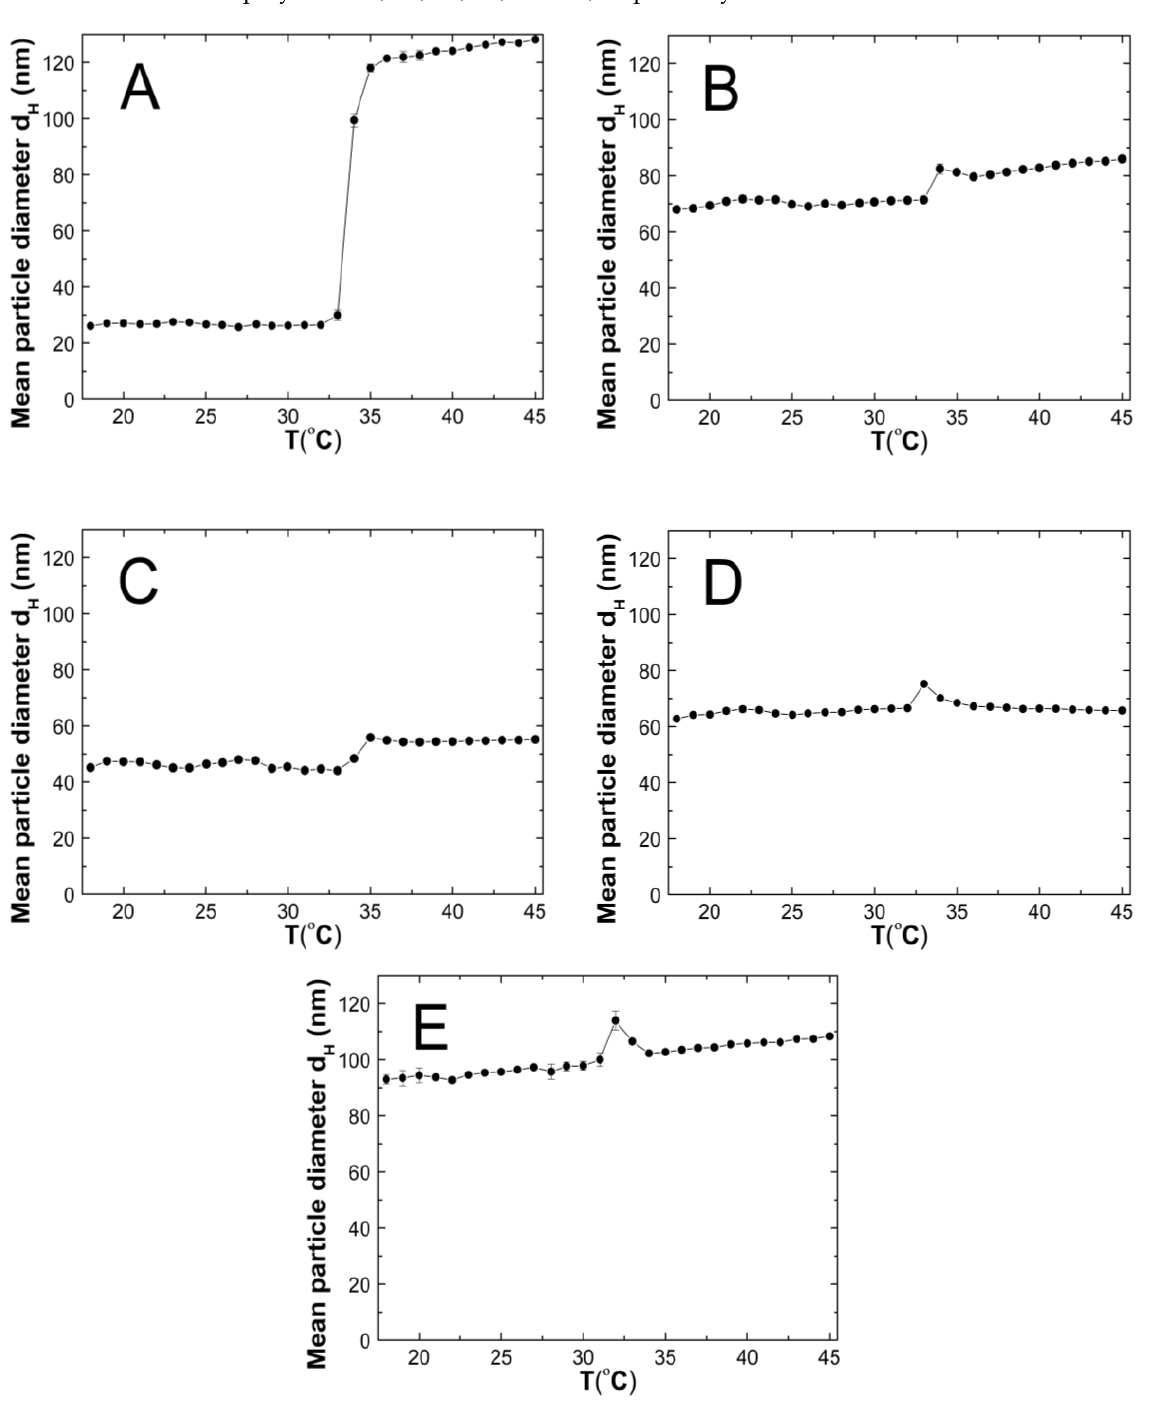
Figure 7 . The influence of temperature on the hydrodynamic diameter of the P1 ( A ), P2 ( B ), P3 ( C ), P4 ( D ), and P5 ( E ) samples as determined by dynamic light P4 ( D ), and P5 ( E ) samples as determined by dynamic light scattering.